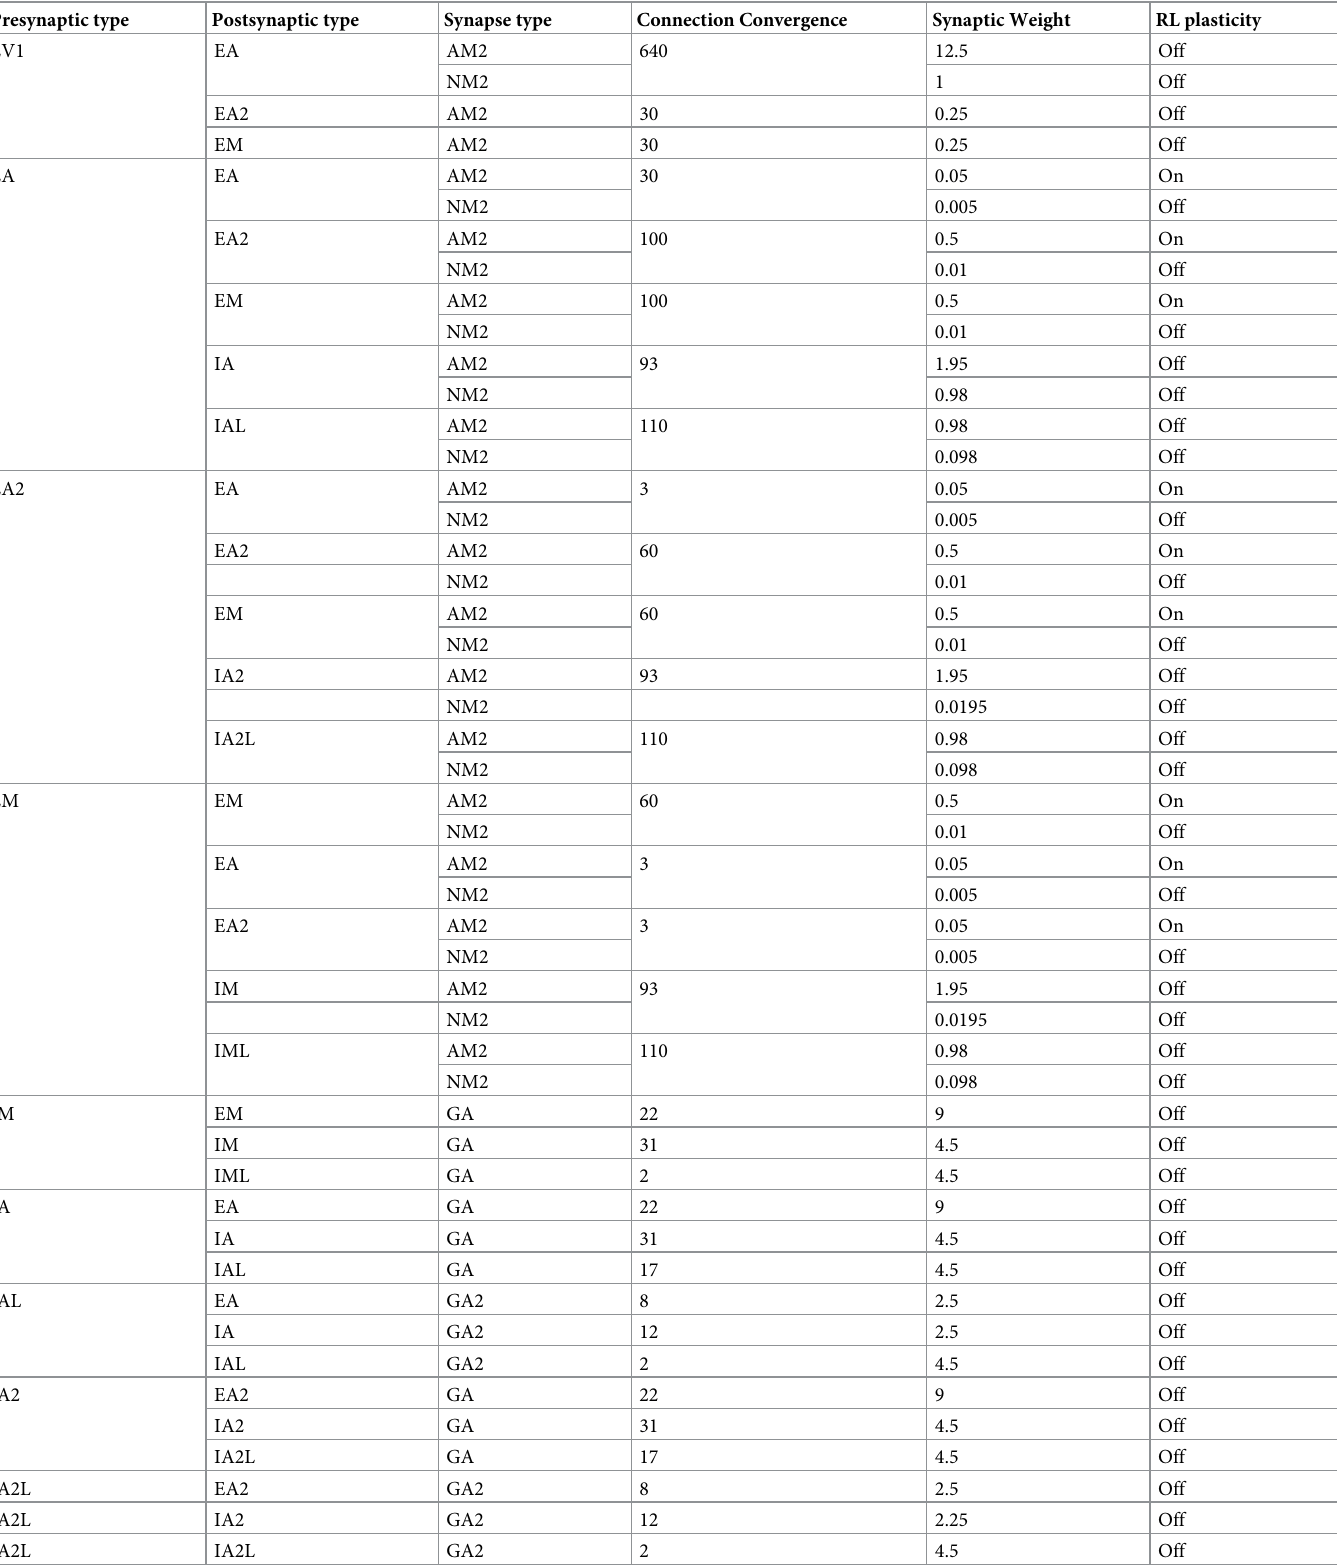
Table 3. Area interconnection probabilities and initial weights for the recurrent